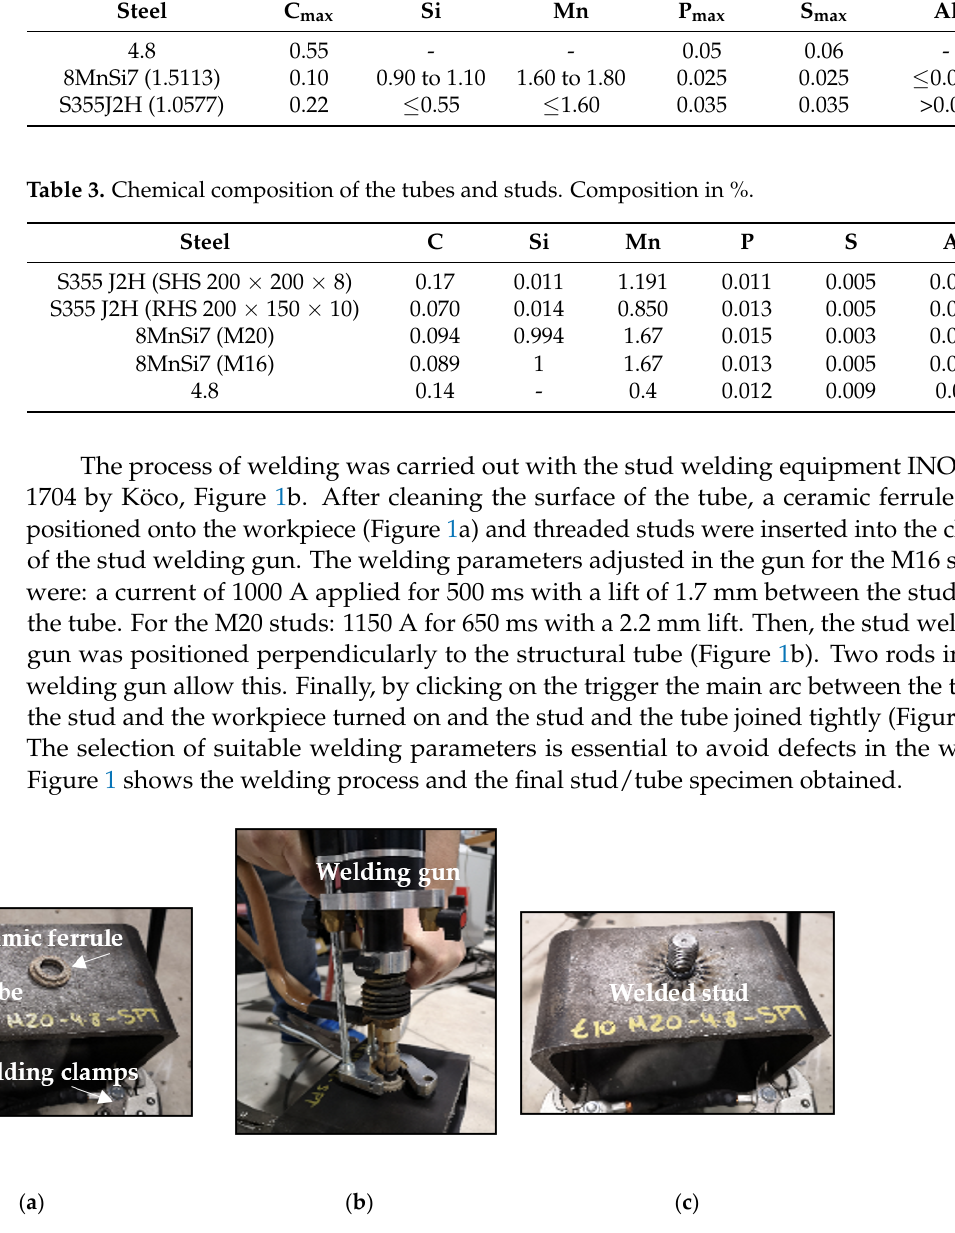
Figure 1. Welding process of the studs with INOTOP 1704 (Köco). ( a ) Positioning of ceramic ferrule; ( b ) welding gun before the arc; ( c ) stud welded to the tube